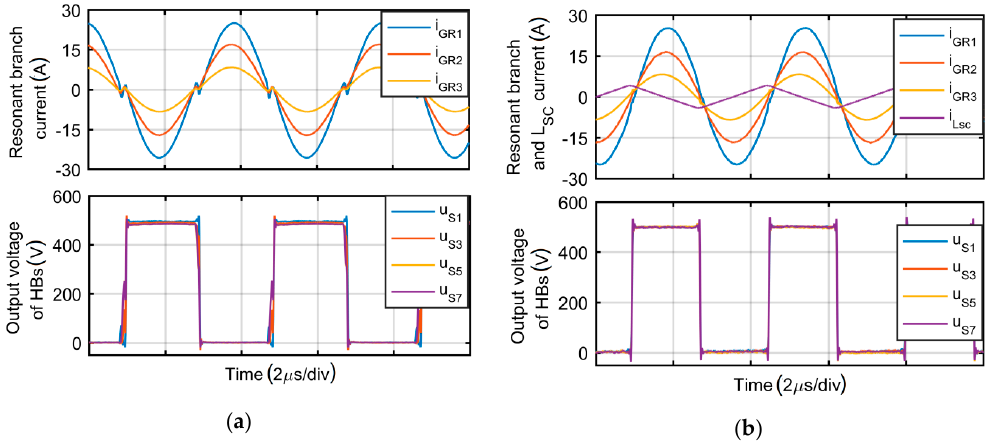
Figure 6. Waveforms of HB (Half Bridge) voltages and resonant branches currents for step-up steady-state operation of: ( a ) base MRSCC at 258 kHz, ( b ) modified MRSCC at 285 kHz. Experimental results of SiC-based converter 5 kW load (oscilloscope data exported and to MATLAB and plotted).